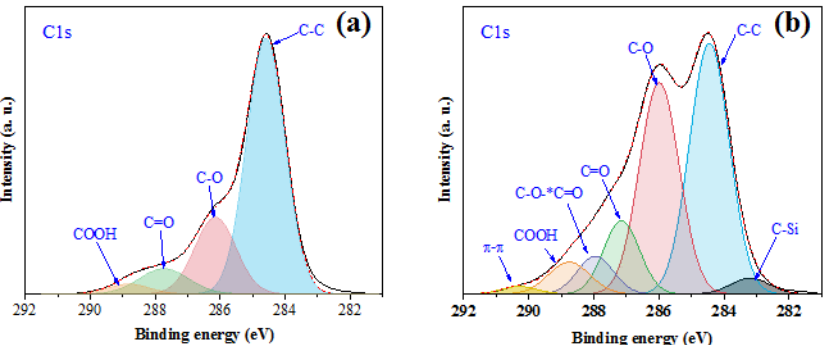
Figure 3. High resolution XPS spectra of the C 1s state for: ( a ) pristine WJF and ( b ) thiol-functionalized WJF. * denotes the carbon species that is responsible for that particular bonding energy.